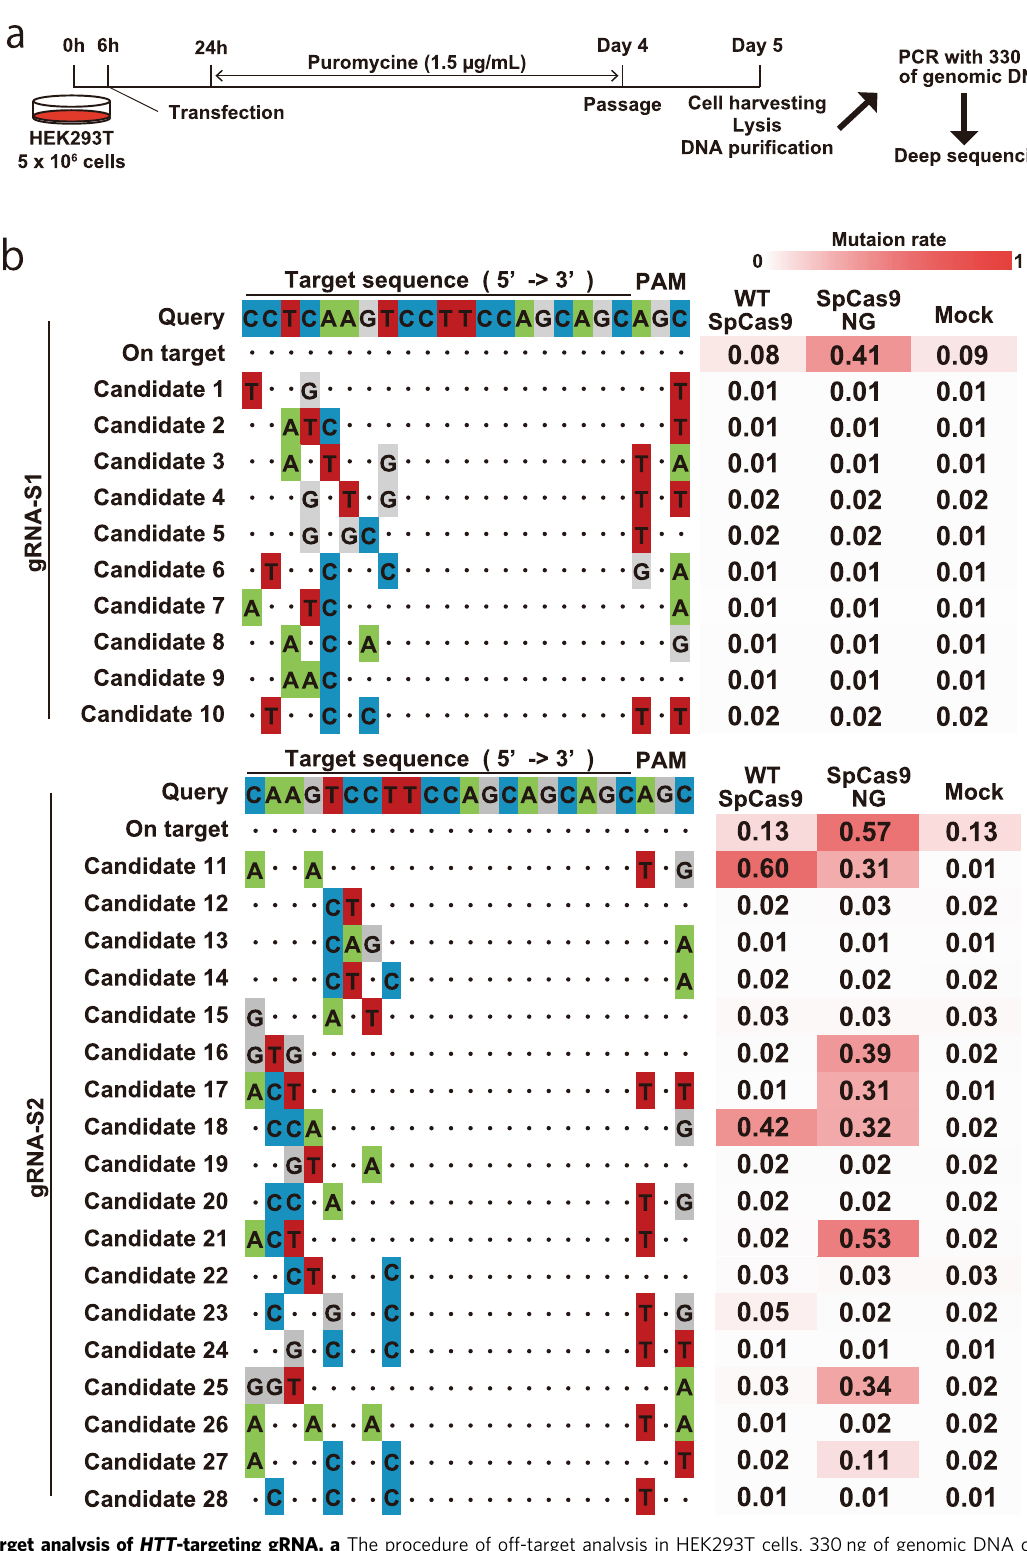
COMMUNICATIONS BIOLOGY| (2021) 4:771 |https://doi.org/10.1038/s42003-021-02304-w|www.nature.com/commsbio